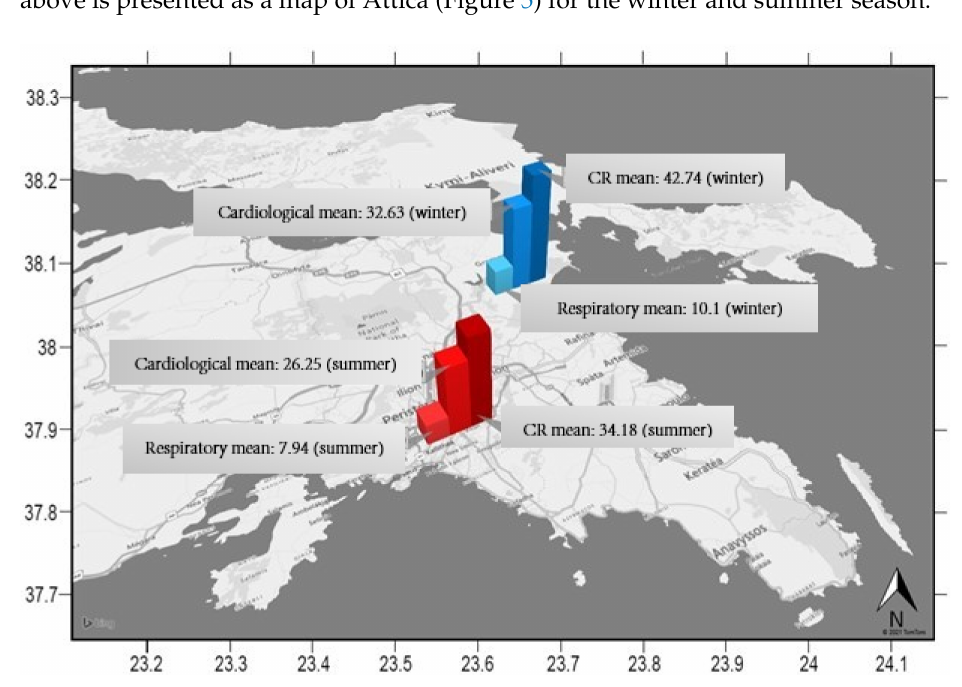
Figure 5. Map of mean values of cardiological, respiratory, and cardiorespiratory mortality (CR) for summer and winter for Attica. Note: The latitude and longitude coordinates are 37.983810 and 23.727539, respectively.